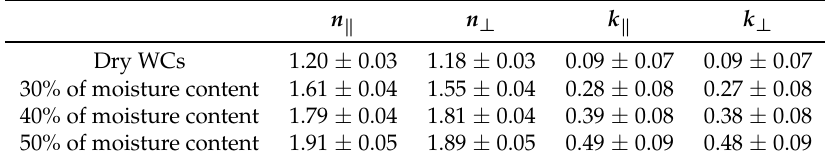
Table 2. Refractive index of WCs ( (cid:107) and ⊥ components) in different polarization states. The real and imaginary parts are determined for the (cid:107) and ⊥ polarization of the radar unit. Radar-determined distance D 2 is 0.426 ± 0.03 m, while the ruler-measured distance D 2 is 0.40 ± 0.02